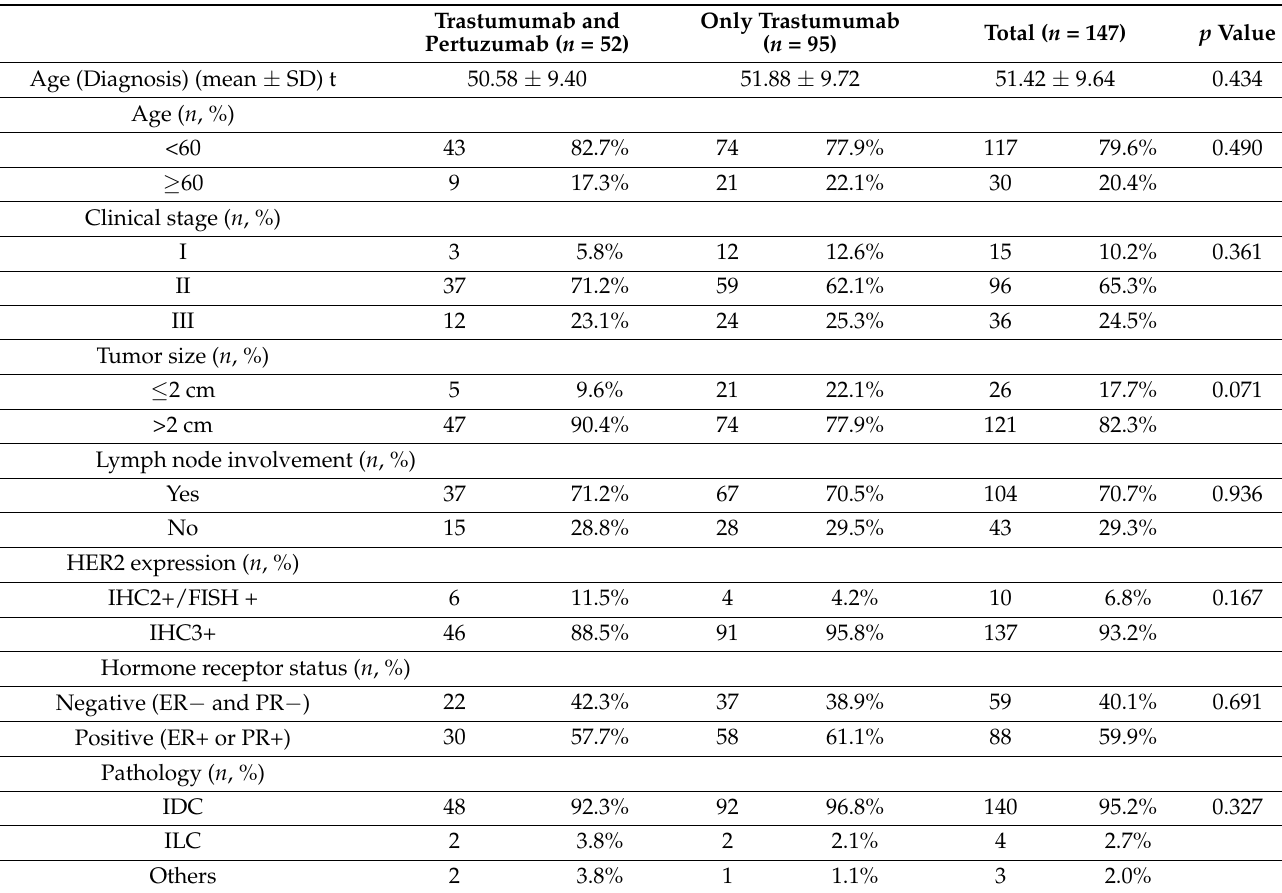
Table 1. Baseline characteristics between single and dual target